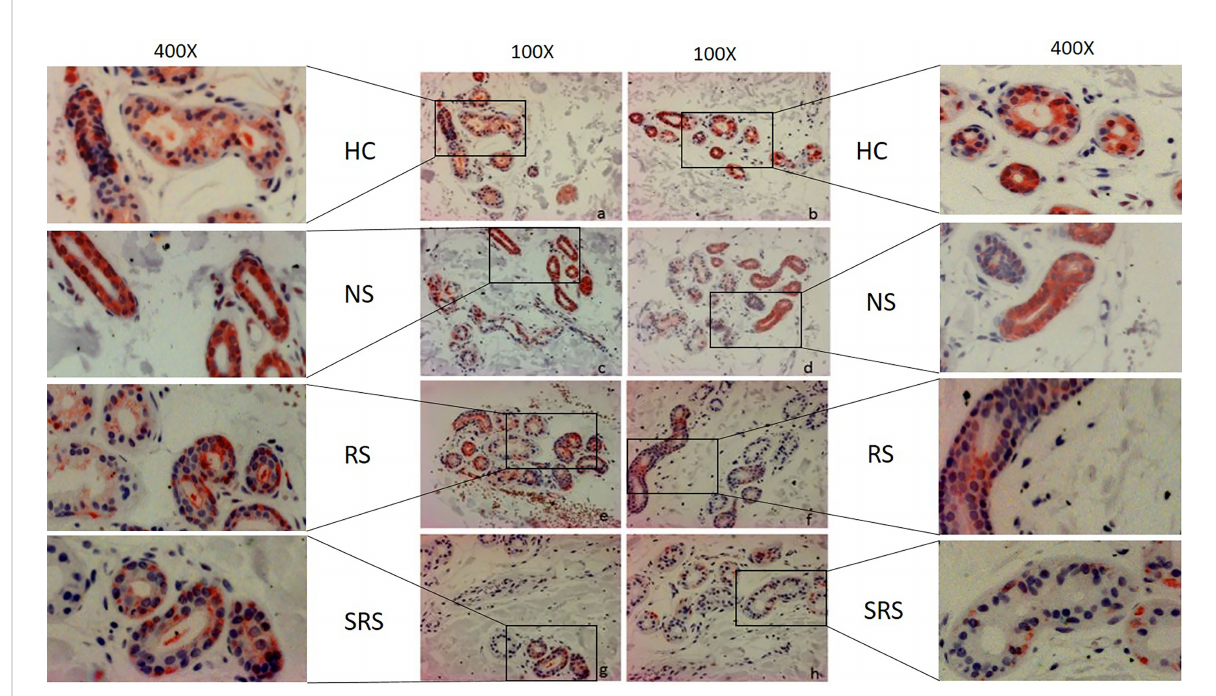
FIGURE 4 Representative immunohistochemical examination patterns of the expression of ACh-E of HC and CholU patients separated per sweating group: a/ c/ e/ g/ non-lesional skin samples taken before provocation, b non-lesion after provocation from the HC group, and d/ f/ h lesional skin samples after provocation from CholU patients. Zoom-in boxes depict the cutouts in higher magni fi cations. HC, healthy controls; NS, normal sweating CholU; RS, reduced sweating CholU; SRS, severely reduced sweating CholU.